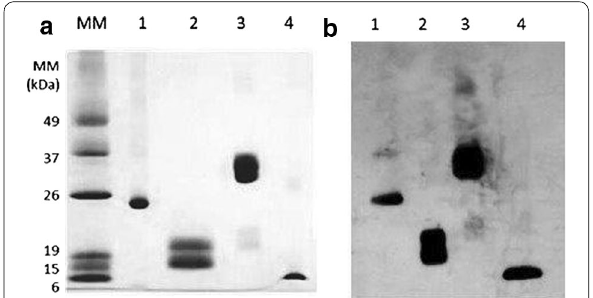
Fig. 1 a SDS-PAGE analysis run in 15% acrylamide gel, stained with Coomassie Blue G, of: (MM) molecular mass markers; (1) E. coli -derived met-hBMP-2 (GenScript) 1 µg, run under non-reducing